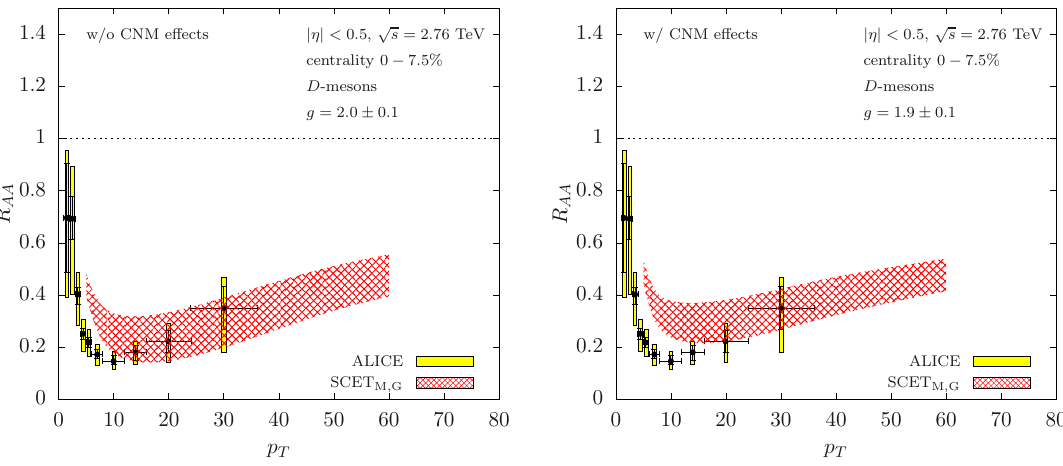
Figure 13 . Nuclear modi(cid:12)cation factor R AA for D -mesons ( D 0 , D + and D (cid:3) + average) without (left) and with (right) CNM e(cid:11)ects in comparison to ALICE data of [9, 15]. We have 2 : 76 TeV, j (cid:17) j < 0 : 5 and 0 (cid:0) 7 : 5% centrality. When CNM e(cid:11)ects are (not) included, we choose the coupling strength as g = 1 : 9 (cid:6) 0 : 1 ( g = 2 : 0 (cid:6) 0 :